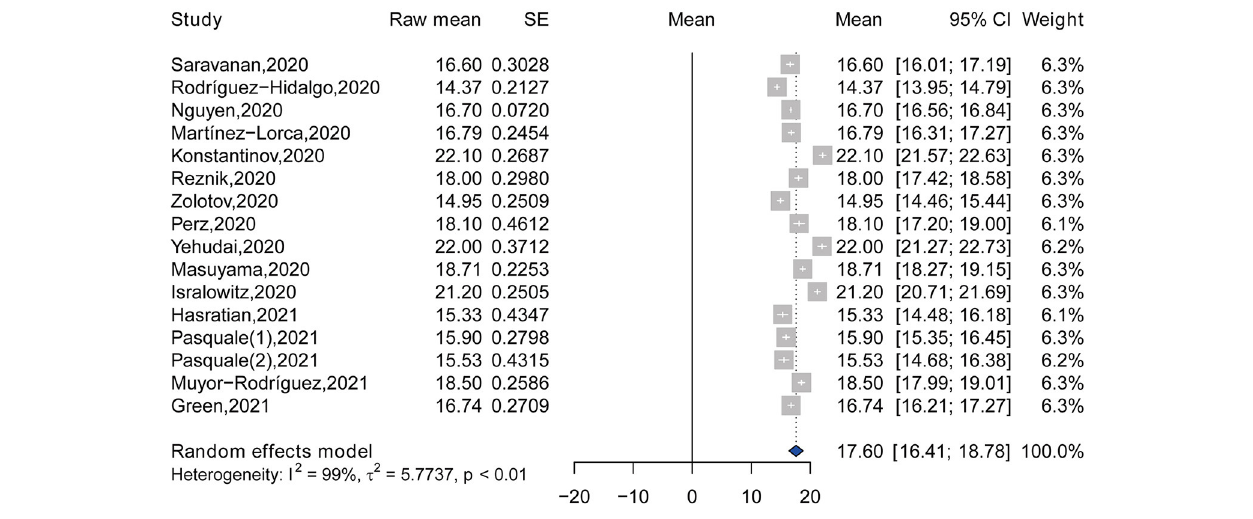
FIGURE 2 | Forest plot showing the pooled mean of fear of COVID-19 ( n = 16).